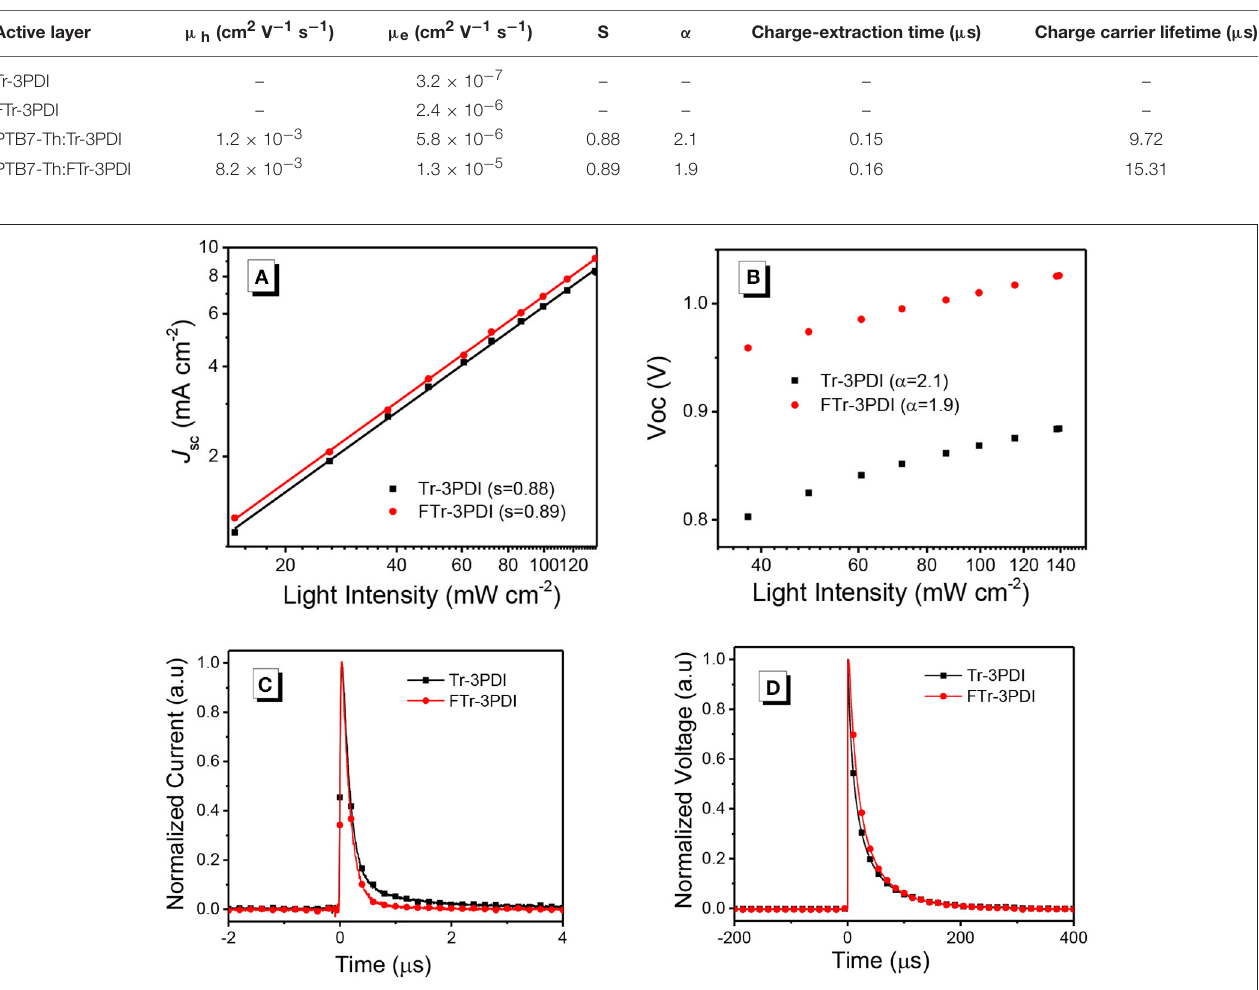
FIGURE 3 | (A) Current density vs. light intensity characteristics, and (B) open-circuit voltage vs. natural logarithm of light intensity characteristics for devices based on PTB7-Th and truxene-PDI acceptors; (C) transient photocurrent measurements; and (D) transient photovoltage of the relevant OSC